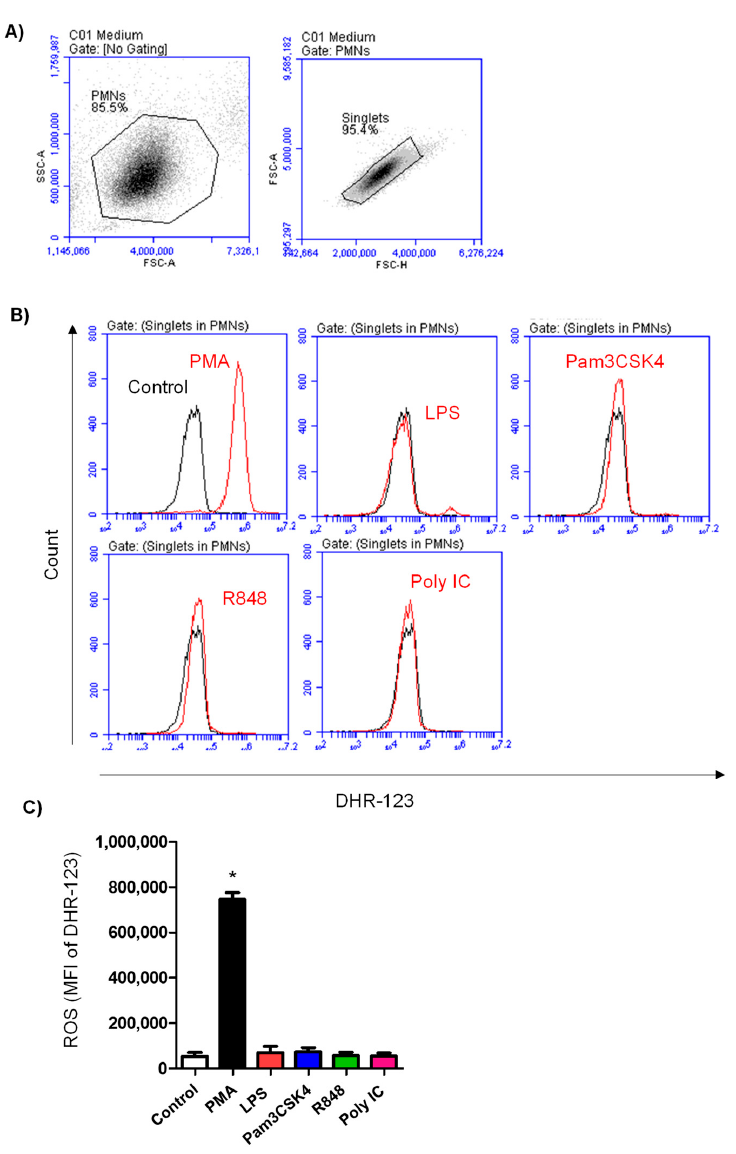
Figure 3. Analysis of ROS generation in neutrophils. ( A ) Non-stimulated and stimulated camel neutrophils were incubated with DHR-123 and analyzed on the flow cytometer. After gating on single neutrophils ( A ), overlapping histograms ( B ) were generated to show the change in DHR fluorescence of stimulated neutrophils (red line) compared with control neutrophils (black lines). ( C ) Mean FL-1 values were measured for control and stimulated neutrophils and presented as mean ± SEM. * indicates significant change in the FSC-A between the means of stimulated and non-stimulated cells with p values less than